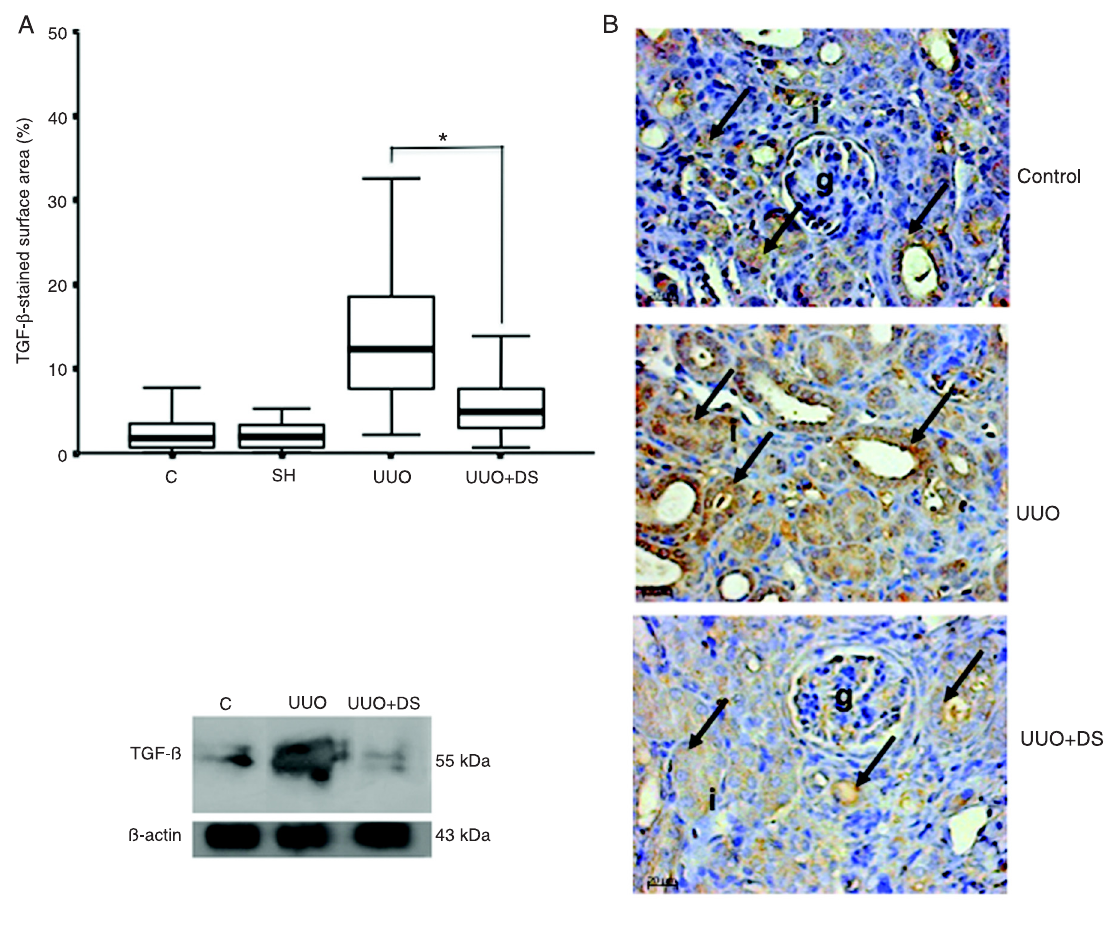
Figure 6. Transforming growth factor beta (TGF-β) content in kidneys from mice submitted to different treatments. A , Immunohistomor- phometry of anti-TGF-β-stained sections of kidneys of mice from group C (control kidney), group sham-operated kidney (SH), group unilateral ureteral obstruction (UUO), and group unilateral ureteral obstruction plus dermatan sulfate (UUO+DS). The horizontal bars represent medians, the boxes represent the 25th and 75th percentiles, and the vertical bars represent the ranges, N = 30. B , The ar- rows in the UUO panel show strong TGF-β-stained areas that seem to be near epithelial tubular cells. Note the less intense staining in control and UUO+DS panels. g = glomerulum; i = interstitium. Magnification 400X. C , The content of TGF-β in rat kidney was analyzed by Western blot using anti-TGF-β. The amount of the load was normalized by the content of actin, as described in Material and Meth- ods. Scale bar = 20 µm. *P < 0.05